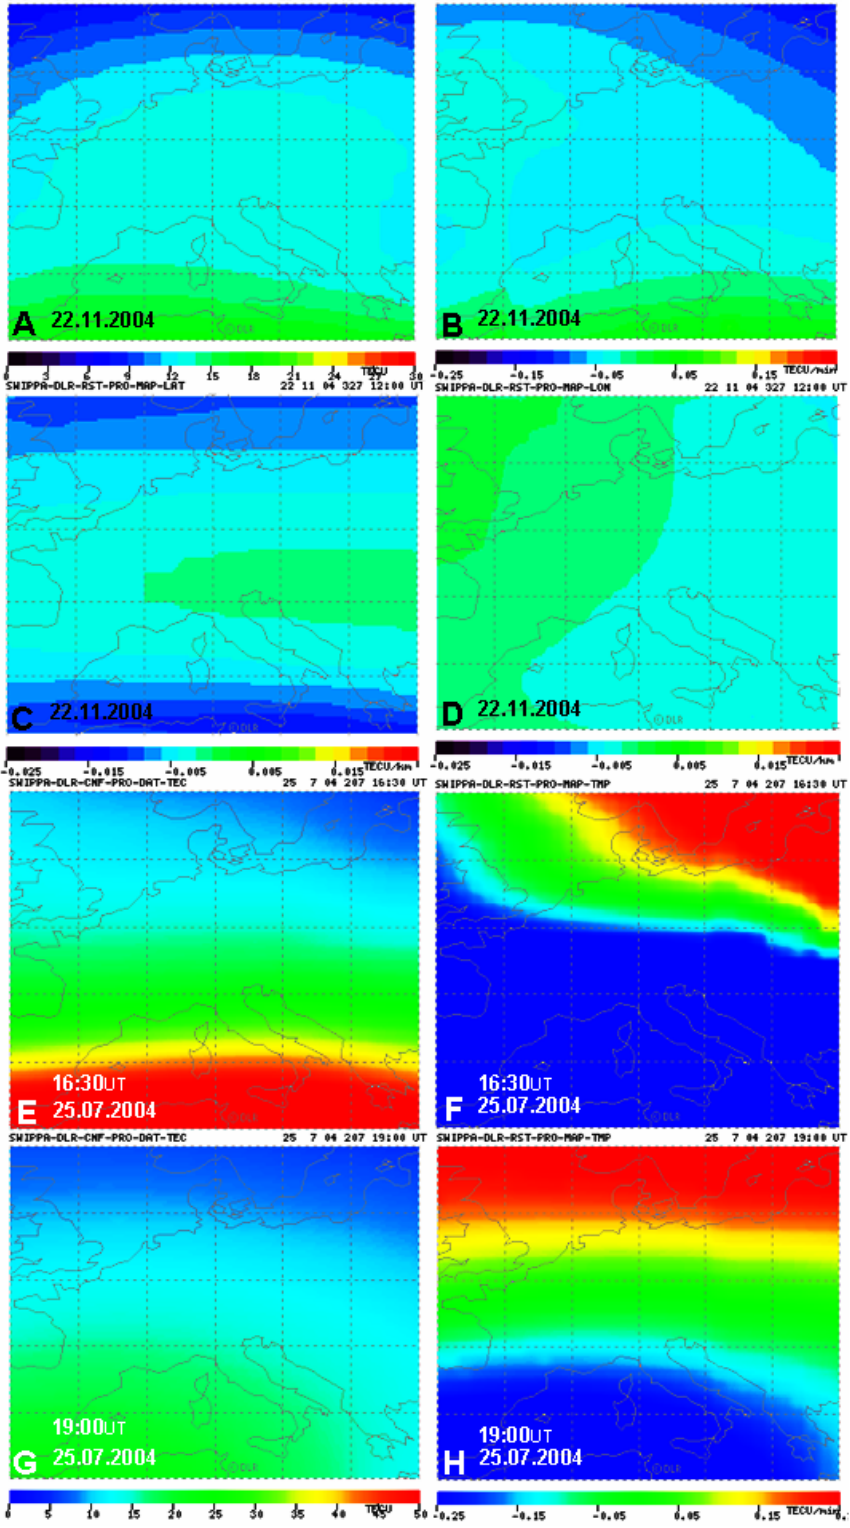
Fig. 6. SWIPPA products and services for the European area. Exemplary maps of the TEC (A) , TEC temporal (B) , latitudinal (C) , and longitudinal (D) gradients at 12:00 UT on 22 November 2004. Maps of the TEC (E, G) and TEC temporal gradients (F, H) on 25 July